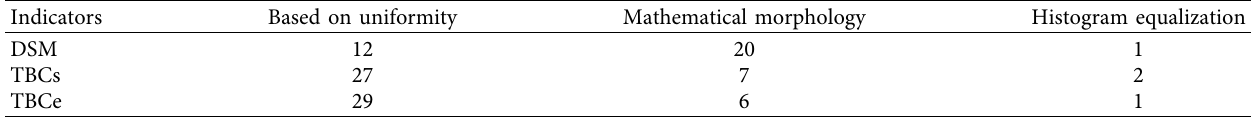
Table 2: Evaluation of image enhancement effects.